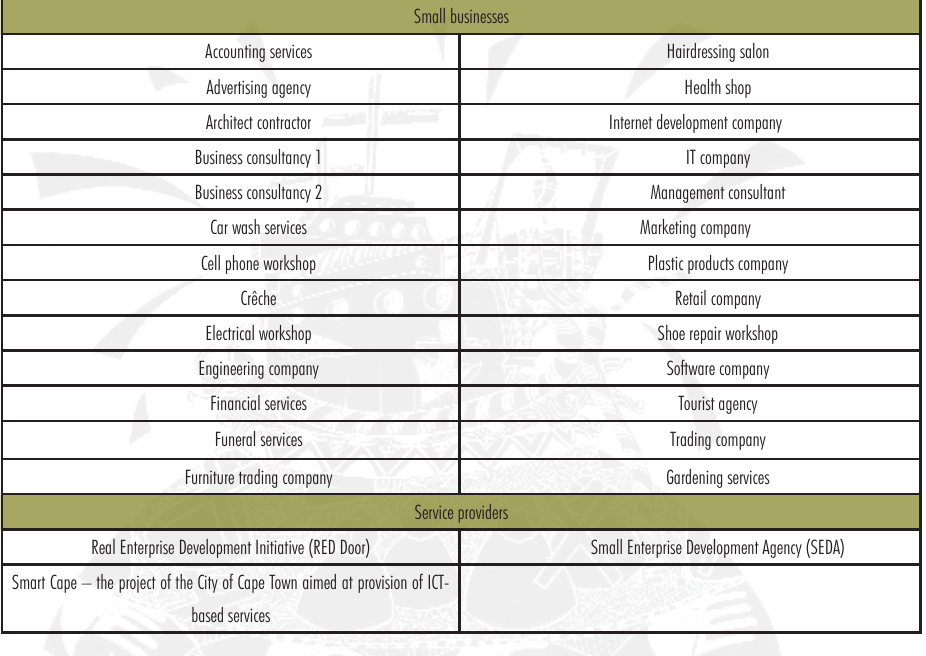
TABLE 1: LIST OF RESEARCHED SERVICE PROVIDERS AND SMALL